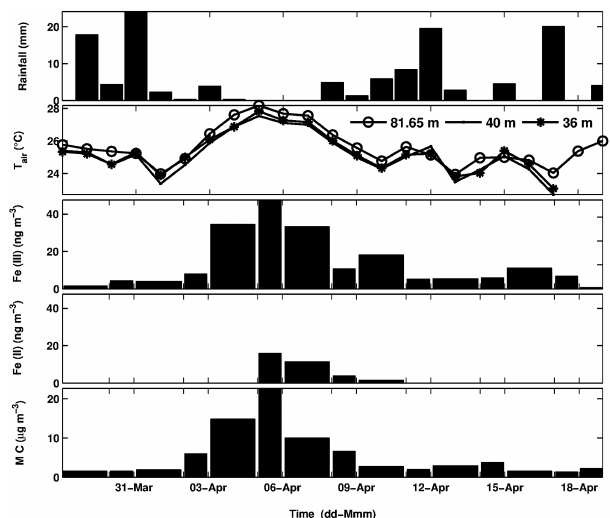
Figure 6. Daily comparison of micrometeorological variables: av- erage air temperature and accumulated precipitation ( T air , rainfall) with measurements of soluble Fe(III) and Fe(II) and mass concen- tration (MC) above the